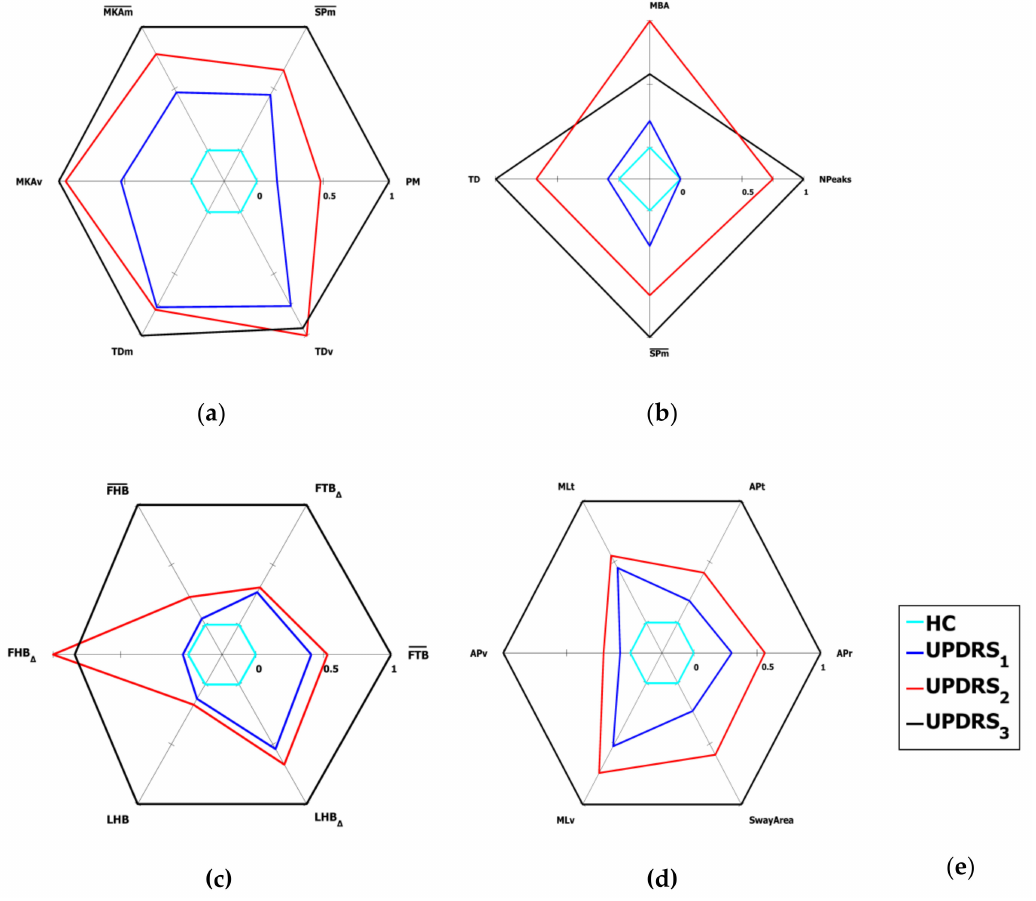
Figure 8. Radar graphs of the mean values of the normalized kinematic parameters of HC and UPDRS severity classes for the lower limbs and postural tasks: ( a ) Leg Agility (LA); ( b ) Arising from Chair (AC); ( c ) Posture (Po); (d) Postural Instability (PS COM ); ( e ) Legend for the radar plots. See Section 5.3 for further details of the graph